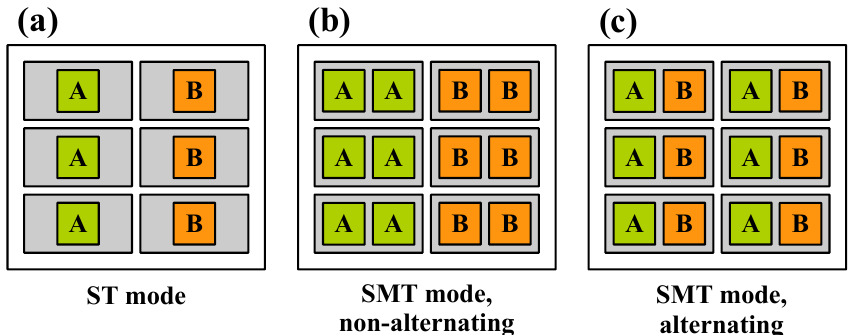
Figure 2. Schematic processes distribution on a hypothetical computing node with six cores (grey-shaded areas) in (a) ST mode, (b) SMT mode with non-alternating processes distribution and (c) SMT mode with alternating processes distribution. “A” and “B” are processes belonging to two different components of the model system sharing the same node. In (b) and (c) two processes of the same (b) or different (c) component share one core using the simultaneous multi-threading (SMT) technique, while in (a) only one process per core is launched in the single-threading (ST)